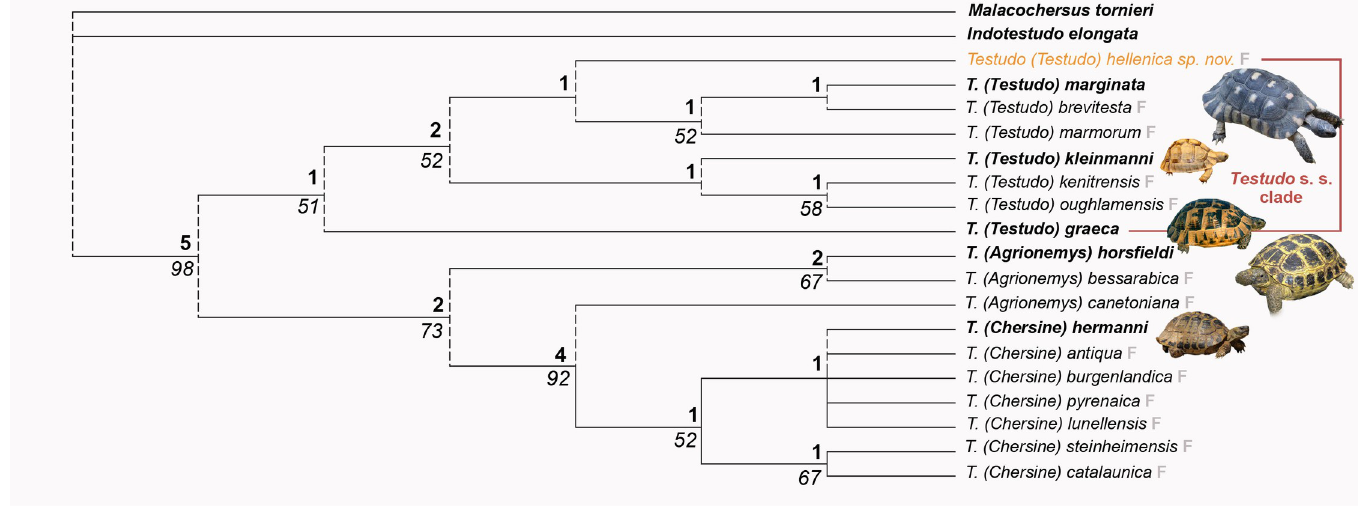
Fig 7. Results of the cladistic analysis corresponding to a strict consensus of 3 equally parsimonious trees of 72 steps (consistency index = 0.61 and retention index = 0.76). The topology of the strict consensus tree obtained is close to the single most parsimonious tree described by Lujan et al. [32] and to the molecular phylogeny tree obtained for the extant taxa [37]. Bremer indices are noted above clades and numbers represents bootstraps values. Extant species are in bold and the fossil species are indicated by an F.